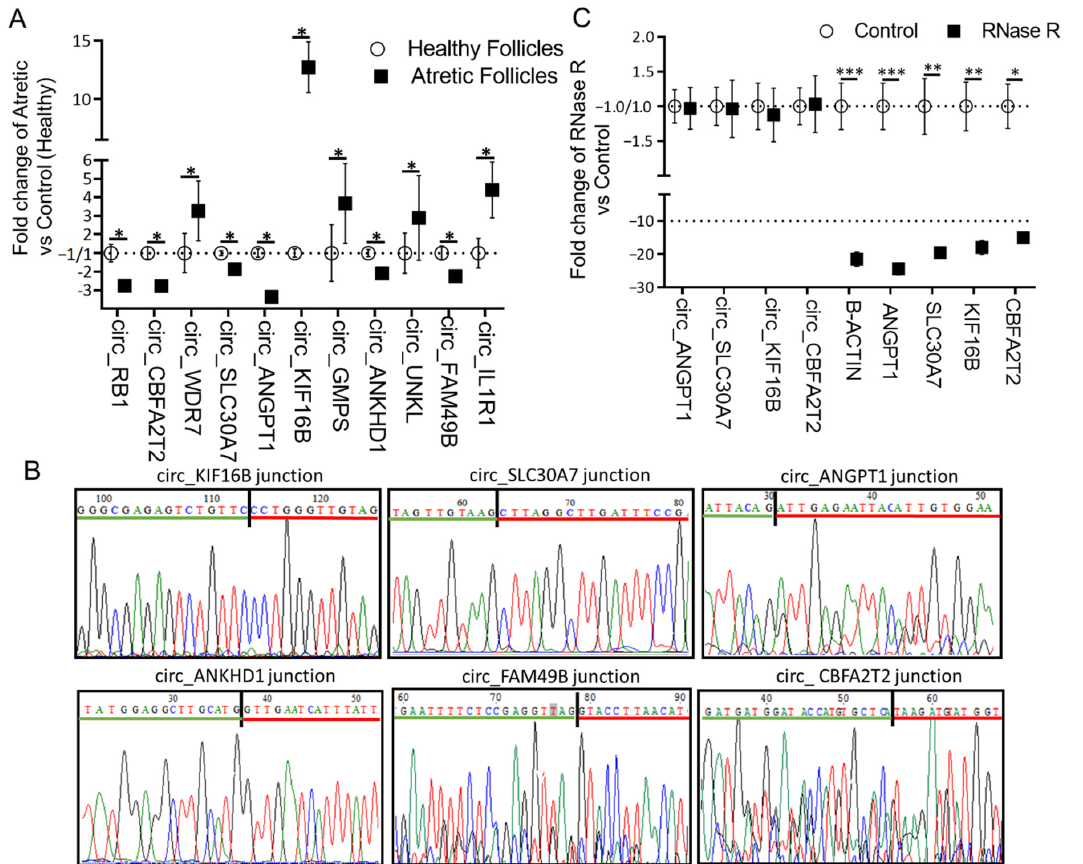
Figure 4. Validation and characterization of circRNAs. ( A ) Relative circRNA expression measured by qRT-PCR. circRNA expression was calculated as a fold change of AA over HA follicles. circRNA expression in HA was set to 1 for up-regulated genes and − 1 for down-regulated genes. ( B ) Representative examples of PCR products purified and sequenced to confirm circRNA junction sites by Sanger sequencing, n = 3. ( C ) qRT-PCR for the abundance of circRNAs ( n = 6) and mRNAs ( n = 6) treated with RNase R. The amount of circRNAs and mRNAs was calculated as fold change of RNase R over controls. The expression values in the controls were set to 1 for up-regulated genes and − 1 for down-regulated genes. *, p < 0.05; **, p < 0.01; ***, p < 0.001. Follicles were isolated in batches at three different time points, each batch containing 15 – 20 ovaries.